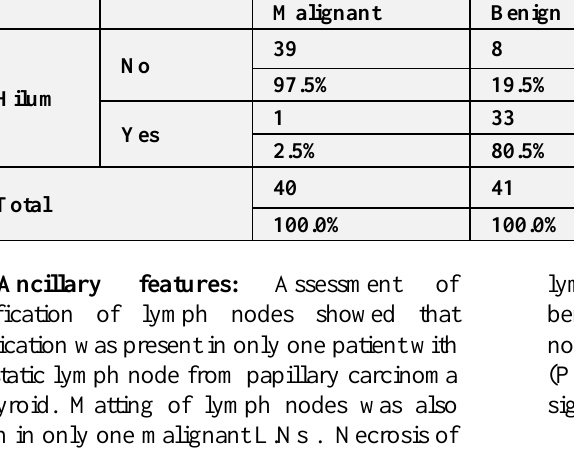
Table (12):- Association between ancillary features and histopathological findings